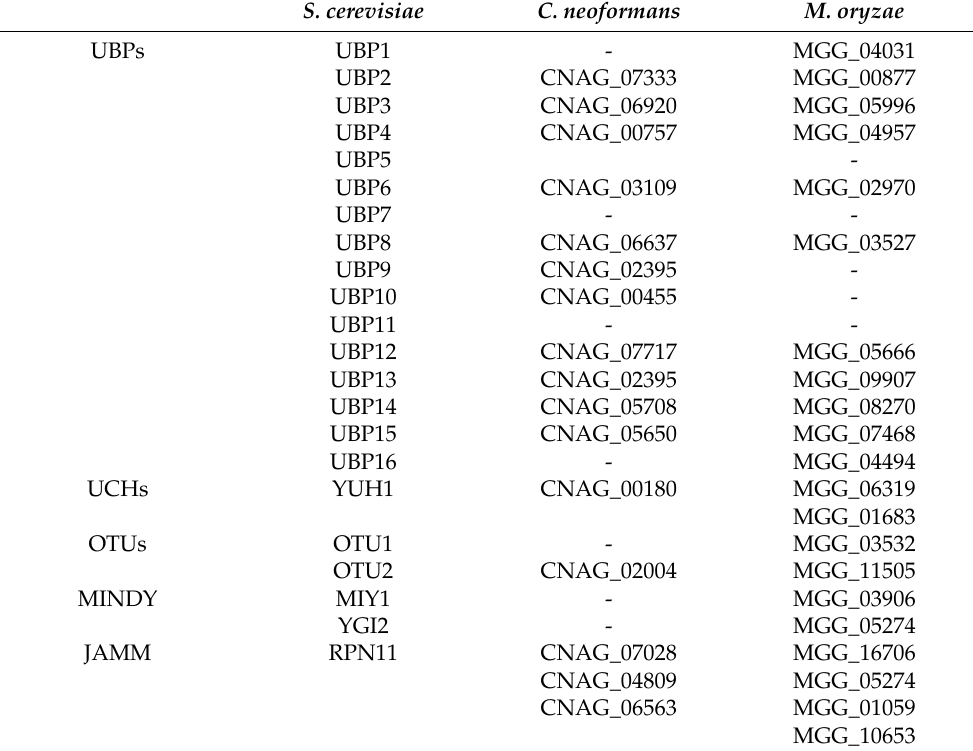
Table 1. DUBs in Saccharomyces cerevisiae, Cryptococcus neoformans, and Magnaporthe oryzae